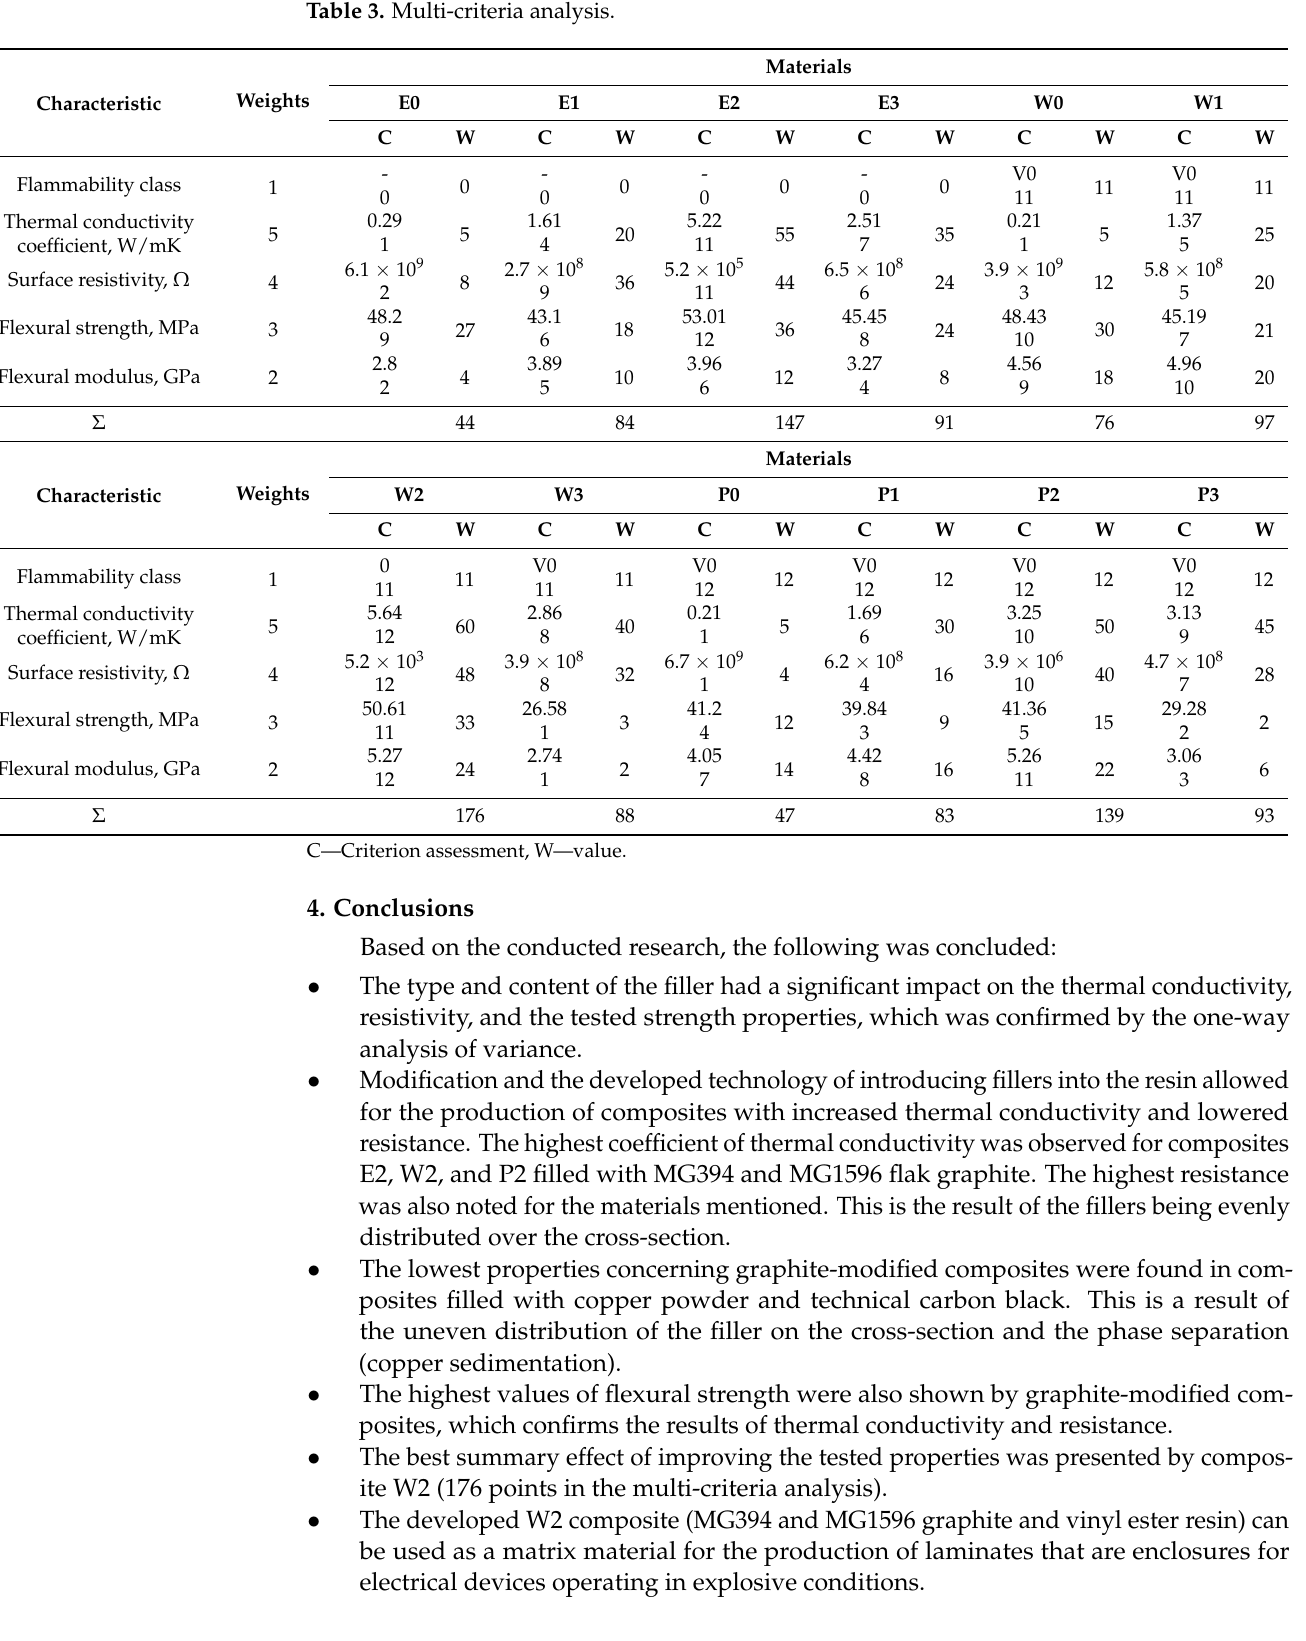
Table 3. Multi-criteria